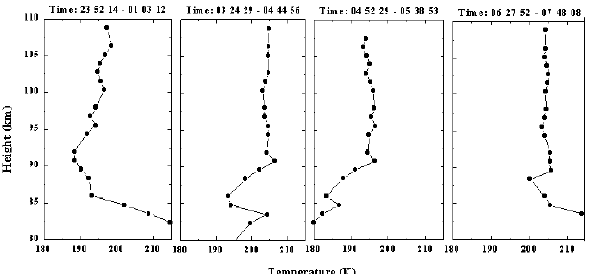
Fig.5 Fig. 5. Temporal variation of temperature profiles obtained on 17– 18 November